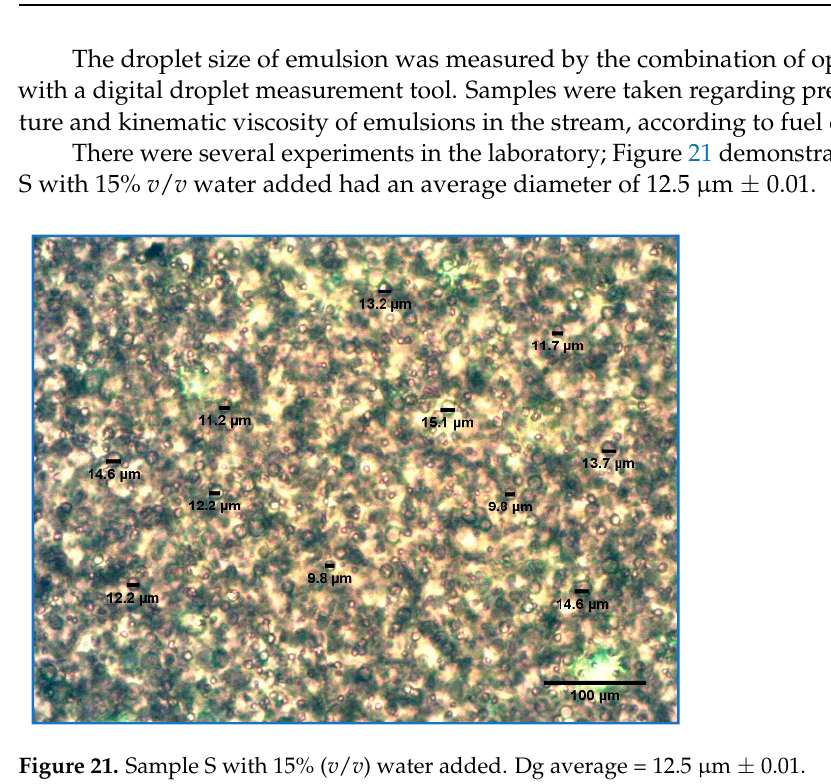
Figure 22. Sample P with 15% ( v / v ) water added. Dg average = 14 µm ± 0.01 . The droplet size of emulsions was compared with samples of N system, an average of diameter of 7.9 µm ± 0.01 was obtained and it is demonstrated in Figure 23.